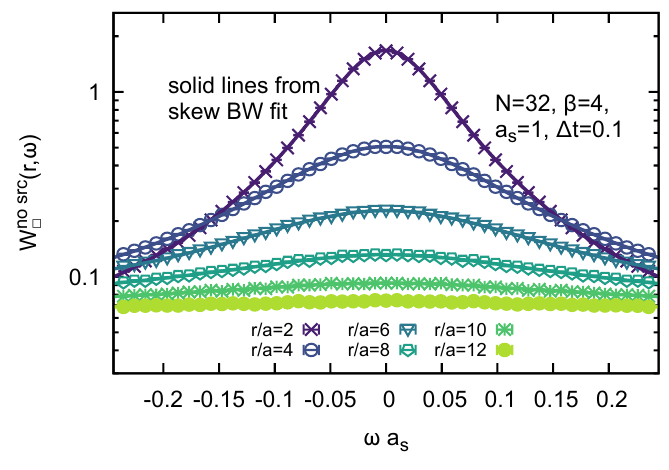
Figure 2 . Discrete Fourier transform (colored points) of the trace of the real-time Wilson loop evaluated at different spatial on-axis separation distances between r = 2 . . . 12 a s on N x = 32 lattices with β = 4 in the absence of a back-reaction between static sources and the surrounding medium. Solid lines indicate the best fit result of the dominant peak structure at zero